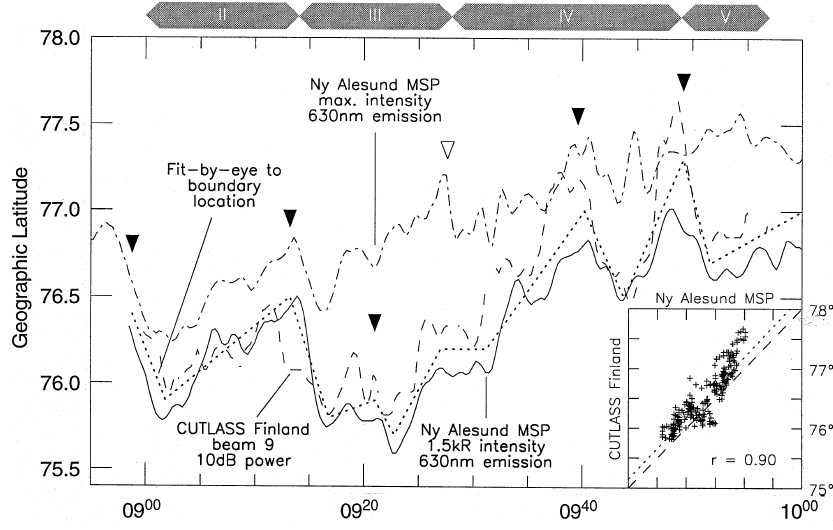
Fig. 5. The locations of the equatorward boundaries of the red line optical emission (solid line) and radar backscatter (dashed line) between 0855 UT and 1000 UT, as determined from the 1.5 kR and 10 dB iso- contours, respectively. The dotted line indi- cates an approximate fit-by-eye to the motion of these boundaries. Also included is the location of the peak in the red line optical emission (dot-dashed line). Arrows indicate the approximate times of the occurrence of equatorward steps of the radar and optical aurora. The inset panel indicates the corre- spondence between the latitudes of the equatorward boundaries of the radar and optical aurora, for the period illustrated